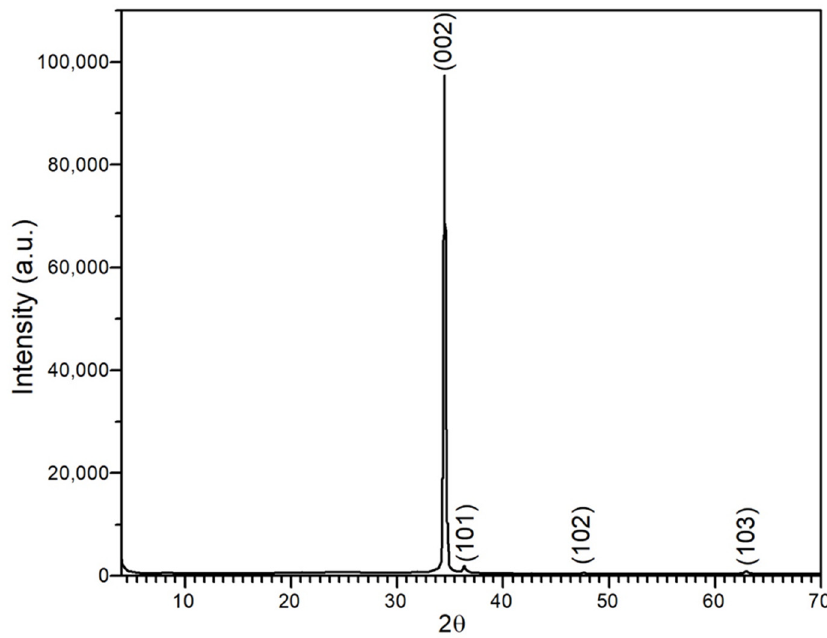
Figure 6. X-ray diffractogram of ZnO:Al deposited on glass. A very intense peak can be identified at 2 θ = 34.7°, which is associated with the crystal plane (002) with θ the the angle of incidence of the X-rays on the sample. This reflection indicates a preferential growth oriented toward the c-axis, corresponding to a hexagonal wurtzite structure.